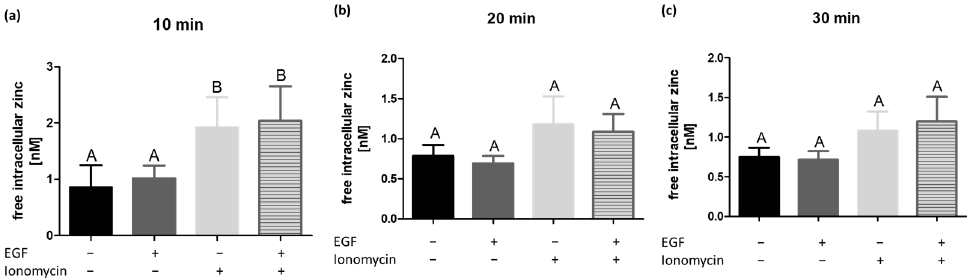
Figure 4. EGF does not induce changes of the intracellular free zinc level. The effect of a stimulation with EGF (25 ng/mL), ionomycin (0.5 µM) and a combination of both on the free intracellular zinc concentration is shown. A549 cells were stimulated for 10 min ( a ), 20 min ( b ) or 30 min ( c ) and measurements were performed by using flow cytometry. Data of n = 4 independent experiments are shown as means + SEM. Statistical significances were calculated using one-way Anova and Tukey’s post-hoc test. Means not sharing any letter are significantly different (A, B).